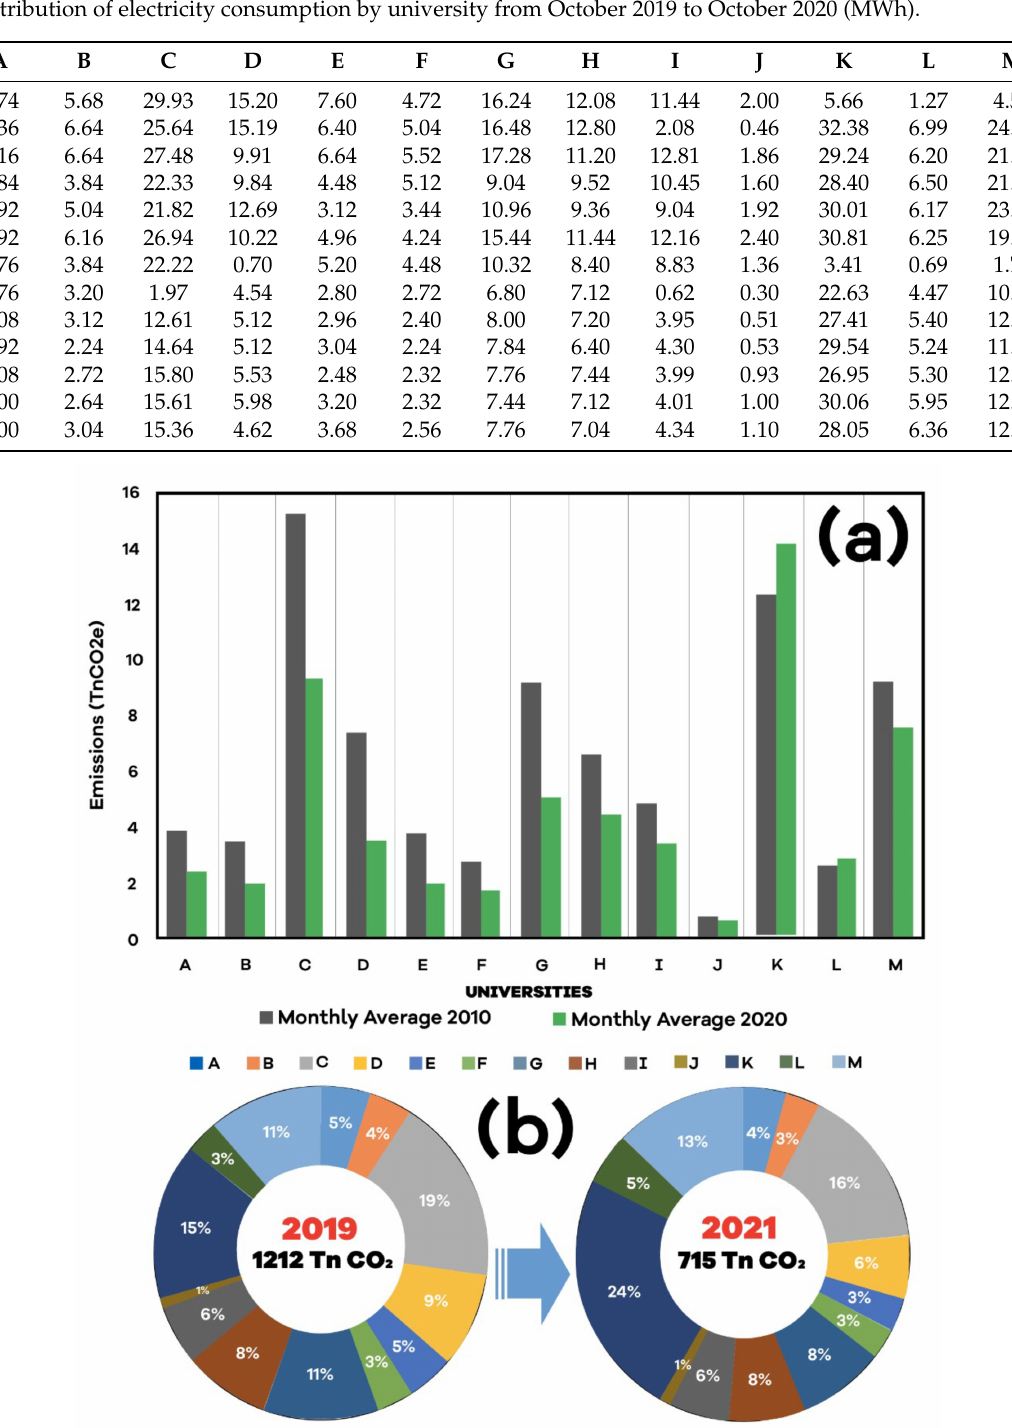
Figure 3. ( a ) Comparative analysis of monthly emissions per university for 2019 and 2020 ( b )